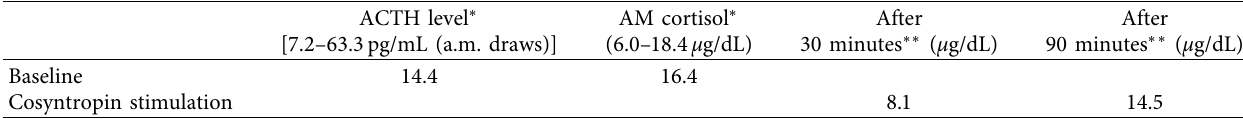
Table 2: Second admission (8 days after initial cosyntropin testing) cosyntropin stimulation test.